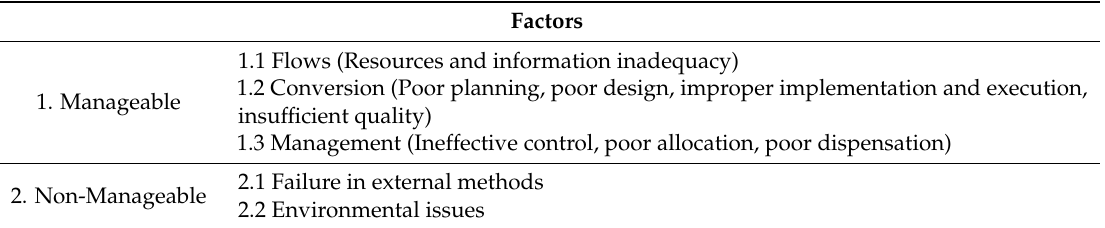
Table 1. The most important factors causing construction project’s